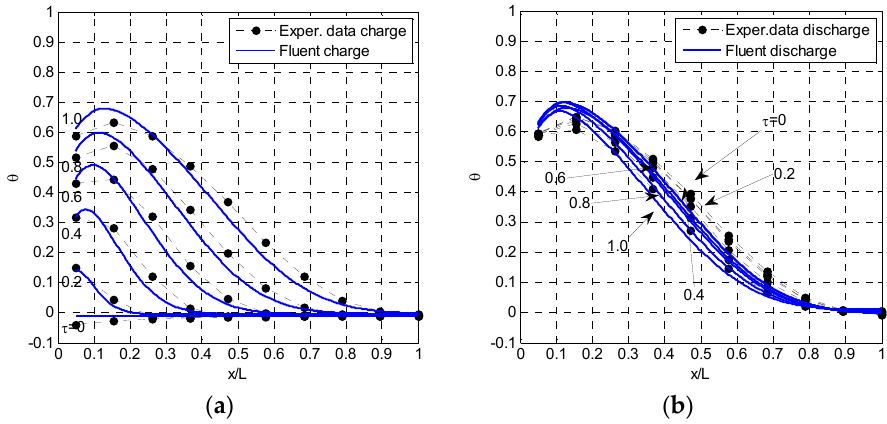
Figure 5. ( a ) Wall temperature distribution for a mass flow rate of 0.15 kg/s during charging phase; ( b ) Wall temperature distribution for a mass flow rate of 0.15 kg/s during discharging phase.